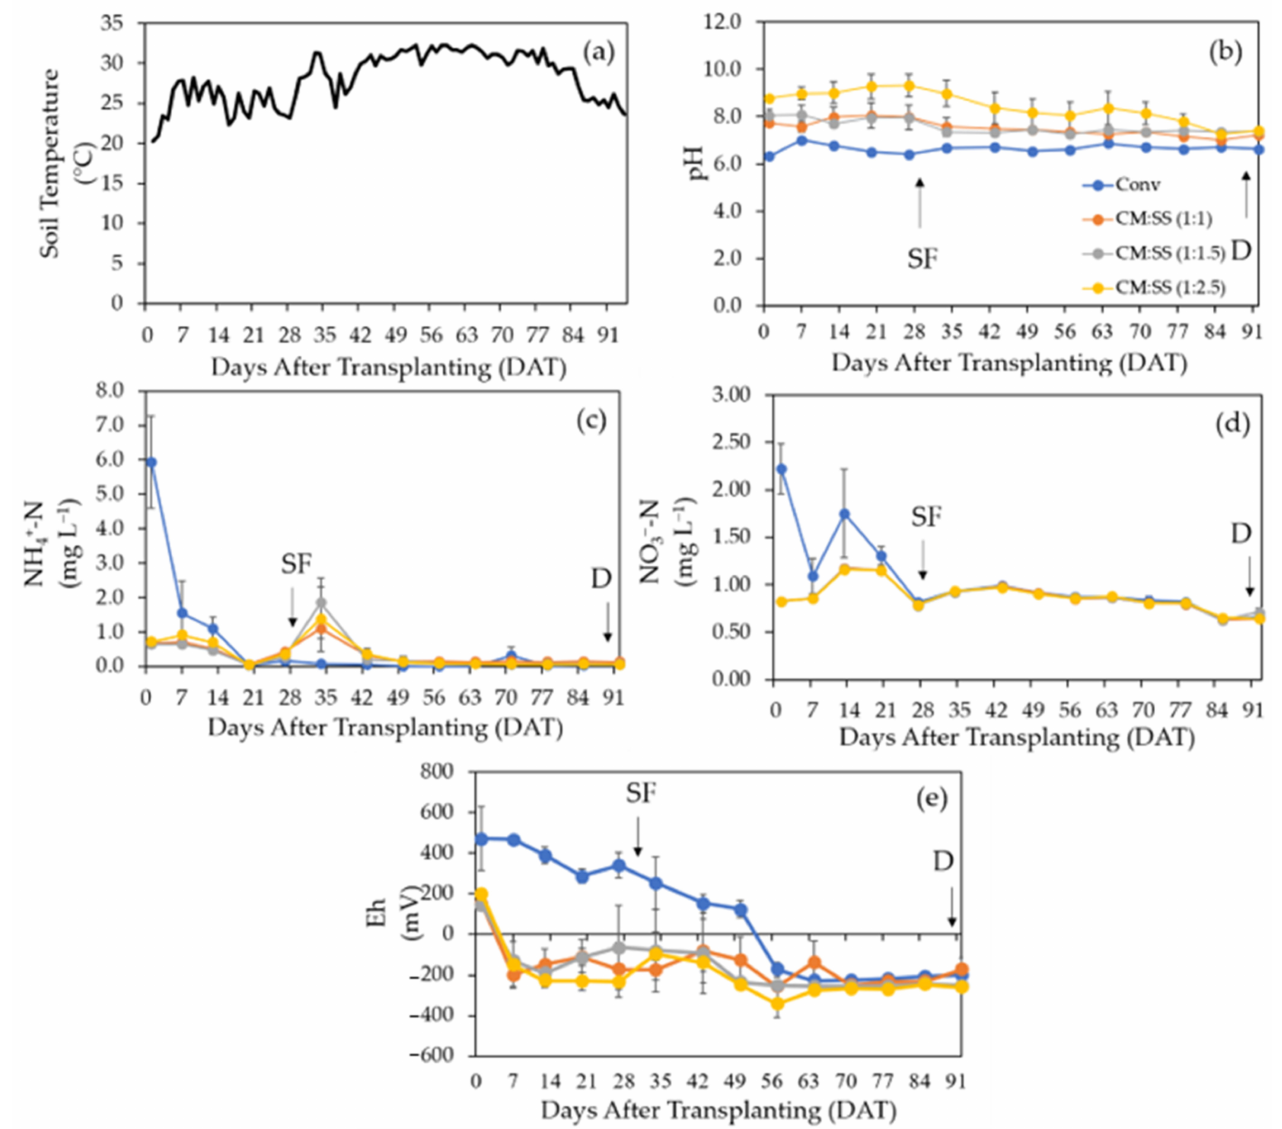
Figure 5. Soil temperature ( a ), Soil water pH ( b ), NH 4+ -N ( c ) and NO 3 − -N ( d ) concentrations, and Eh ( e ) in each treatment during the pot experiment. All values are expressed as mean. Conv: conventional, CM: chicken manure, SS: steel slag, SF: supplementary fertilization, D: the time when the pot was dried. Error bars represent standard